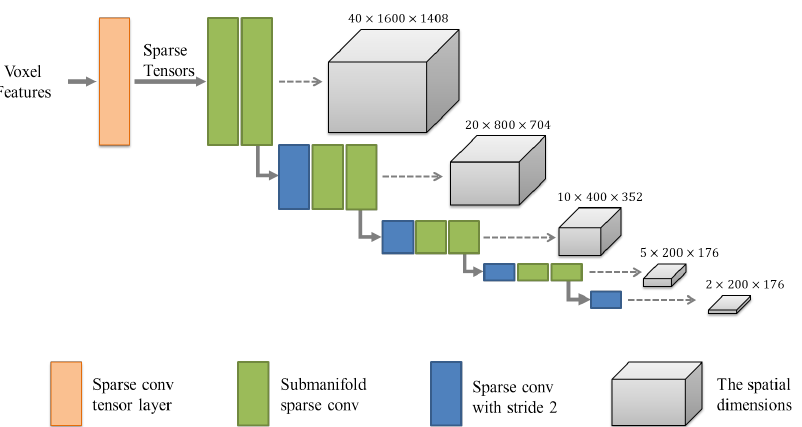
Figure 2. The structure of the 3D sparse convolutional middle extractor. The orange box is the sparse convolutional tensor layer, which is used to convert voxel features into 4D sparse tensors. The blue boxes are sparse convolutional layers with stride = 2, and the green boxes are submanifold convolutional layers. The gray cuboids are used to show the changes in the spatial